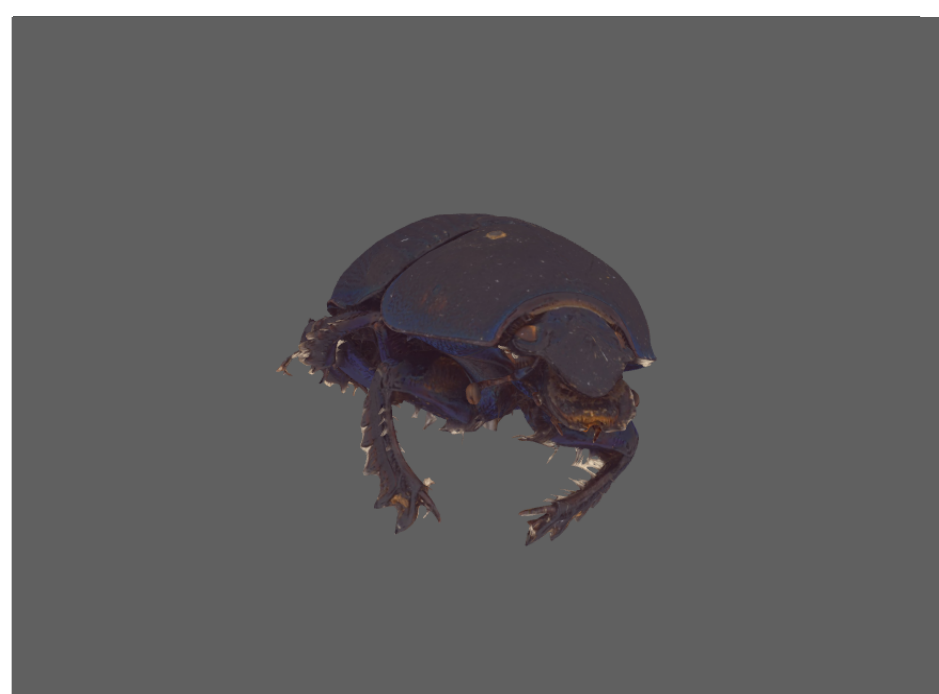
Figure 18. Interactive, textured 3D-model of Anoplotrupes stercorosus (21 mm body